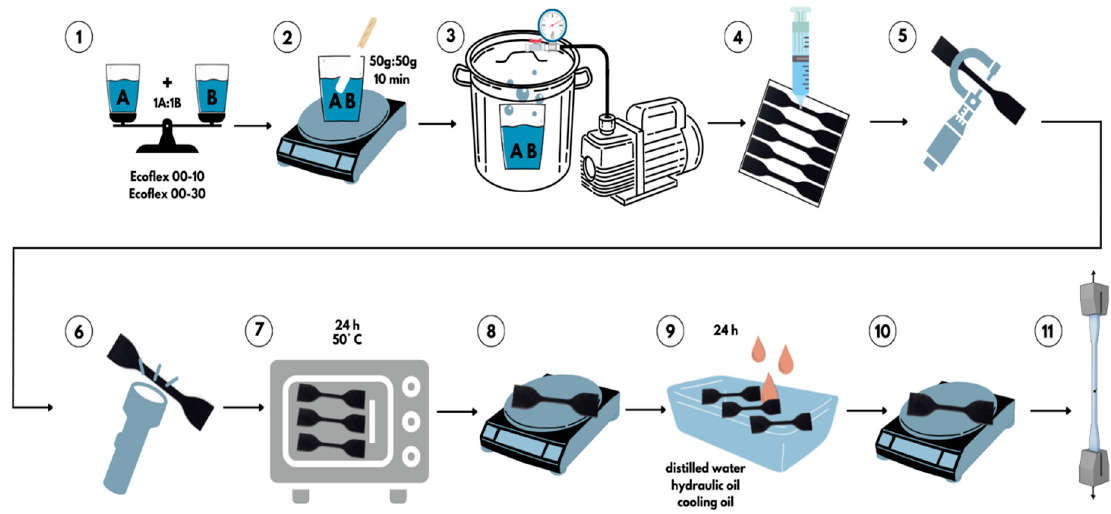
Figure 1. Specimen casting stages: 1—Part A and Part B in equal quantities, 2—Mixing the two parts, 3—Removal of air bubbles with the vacuuming system, 4—Pouring into the mold and left to harden for 4 h, 5—Measurement of specimens, 6—Qualitative inspection of specimens, 7—Drying specimens in the oven, 8—Weighing of specimens after drying, 9—Submerge specimens in fluid for 24 h, 10—Measuring the absorption level, 11—Uniaxial tensile tests on Titan 2 Universal ma- chine.